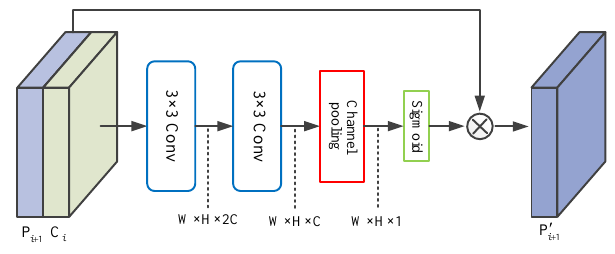
Figure 3. Structure of the adaptive enhancement